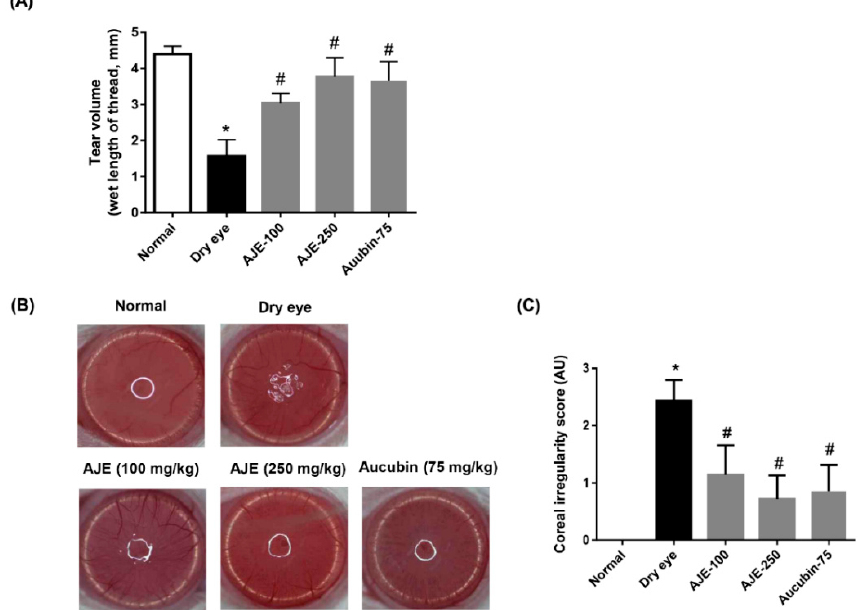
Figure 5. Effects of AJE and aucubin on tear secretion and corneal irregularity in dry eye rats. ( A ) Tear volume was measured using the phenol red thread test. Tear volume was expressed in millimeters of thread that became wet by the tear and turned red in color. ( B ) Reflected images of a white ring from the fiberoptic ring illuminator of a stereomicroscope. ( C ) Corneal irregularity was graded according